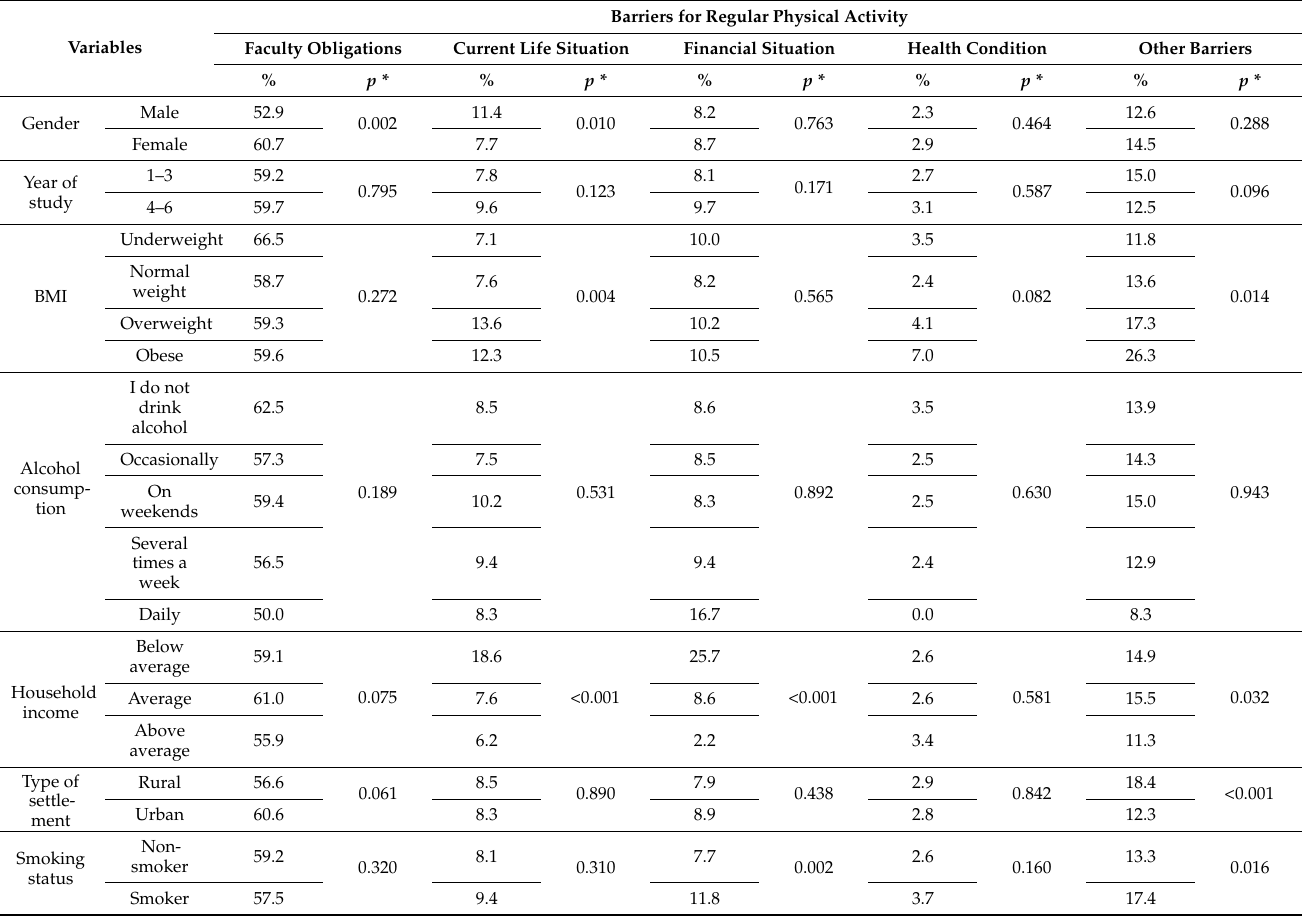
Table 7. Barriers for regular physical activity among medical students, according to gender, year of study, body mass index (BMI), alcohol consumption, household income, type of settlement, and student smoking